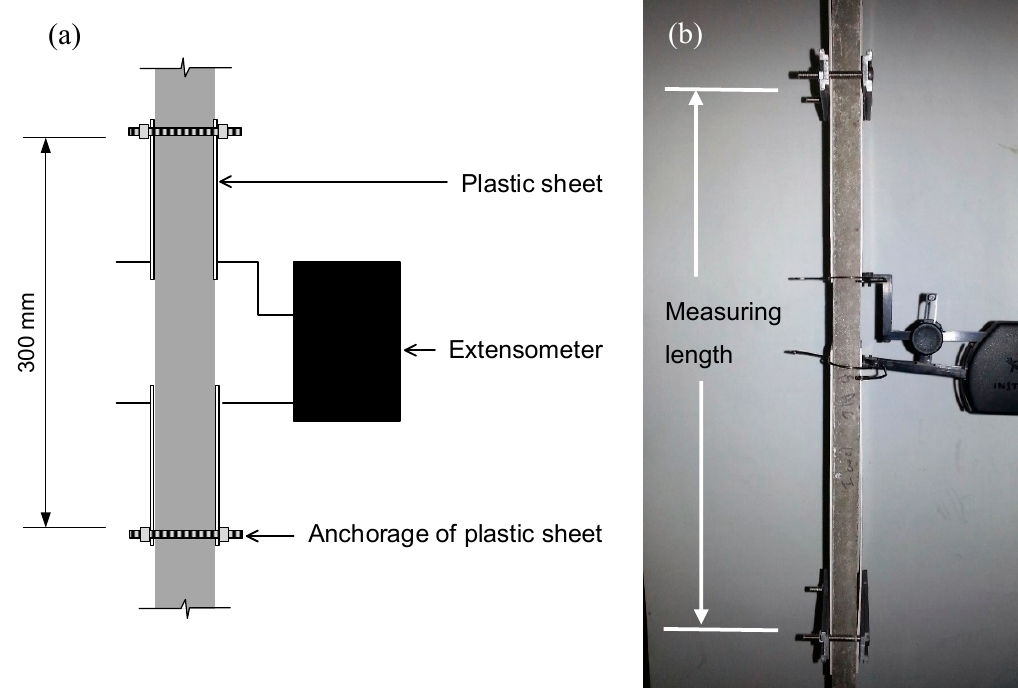
Figure 4. Sketch ( a ) and view ( b ) of the deformation measurement setup.